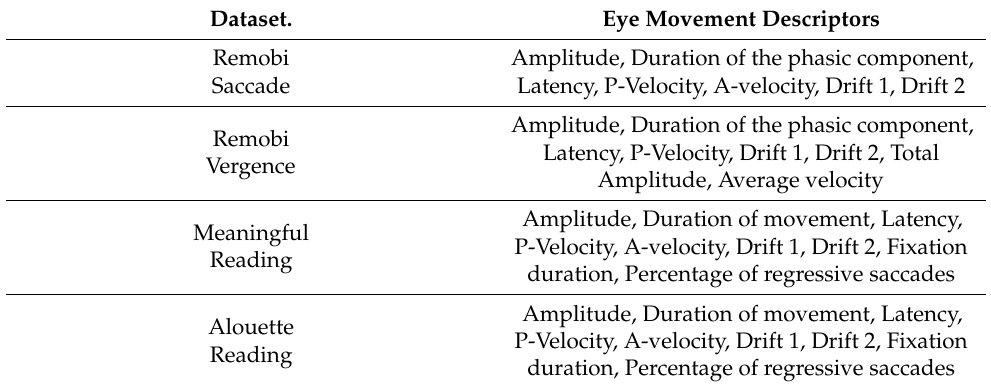
Table A1. List of the descriptor used for each model.